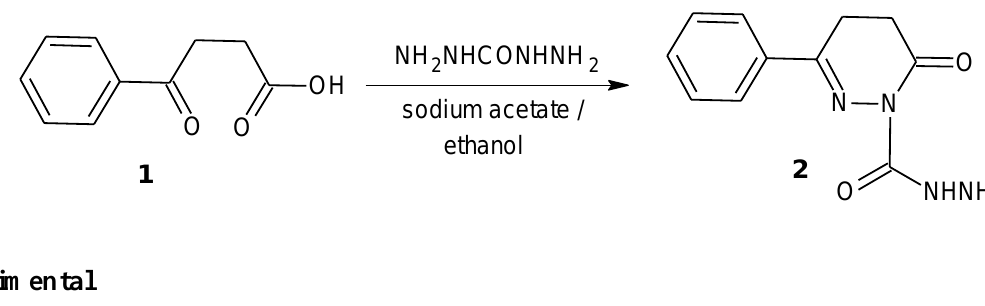
Figure 1. Synthetic route to the title compound 2